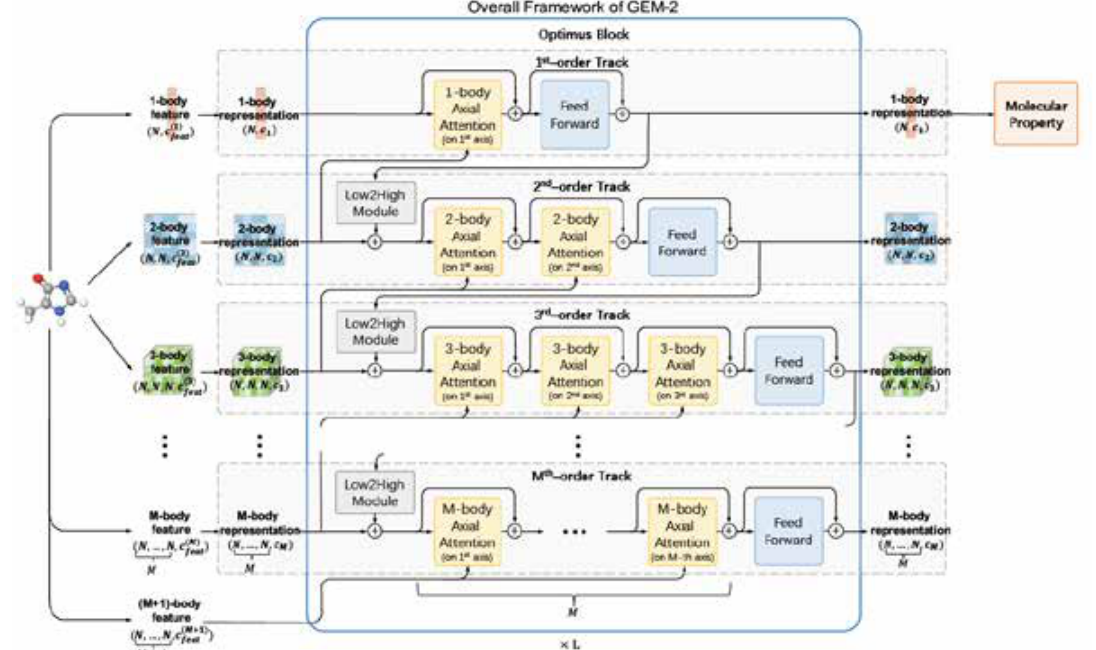
Figure 7 Each of them learns the long-range relationships between multibody of the same order, and information of different orders can also be transferred across the tracks to enhance the modeling effect [25].